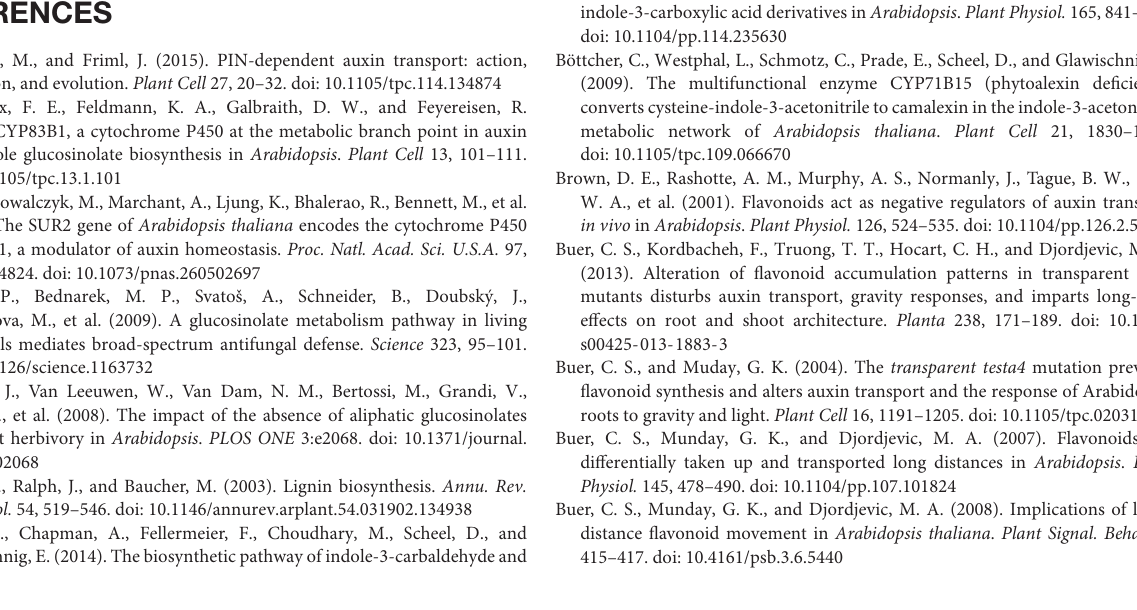
FIGURE S1 | Multivariate analysis of metabolites from shoots and roots of wild-type (wt) and PCS1 knockout mutant ( cad1-3 ) grown under control conditions or after Cd exposure for 24 h. The LC-ESI-MS-detected m/z features were used as X variables. The O2PLS-DA S-loading plots p1 vs. pq(corr)1 showed the correlation of the metabolites (black squares, the q part of the model) [pq(corr), correlation between p and q] in shoots and roots with the two plant lines (the p part of the model). The models are statistically significant. TABLE S1 | List of identified metabolites from shoots and roots of wild-type and PCS1 knockout mutant ( cad1-3 ) grown under control conditions or after Cd exposure for 24 h. The analysis was performed in negative ion mode (LC-ESI-MS). The list includes the fragmentation patterns (MS/MS and MS 3 ) and the putative identifications with the corresponding references. m/z , mass to charge ratio; rt, retention time. The MS 3 fragmentation patterns were generated in MS/MS column by Collision Induced Dissociation (CID) of the in bold and underlined ion. TABLE S2 | List of identified auxins from shoots and roots of wild-type and PCS1 knockout mutant ( cad1-3 ) grown under control conditions. The analysis was performed in negative ion mode, except for the indole-3-acetic acid methyl ester (MeIAA), recorded in positive ion mode. Selected reaction-monitoring conditions were for protonated or deprotonated auxin metabolites ([M + H] + or [M − H] − ). m/z , mass to charge ratio; rt, retention time; Q1, precursor ion selected in Q1 mass filter; Q3, product ion selected in Q3 mass filter; Q2, collision energy